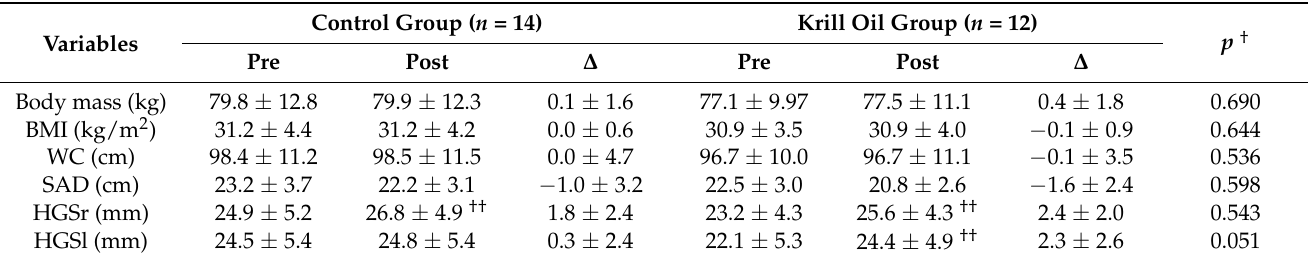
Table 1. Anthropometric and handgrip strength measurements of